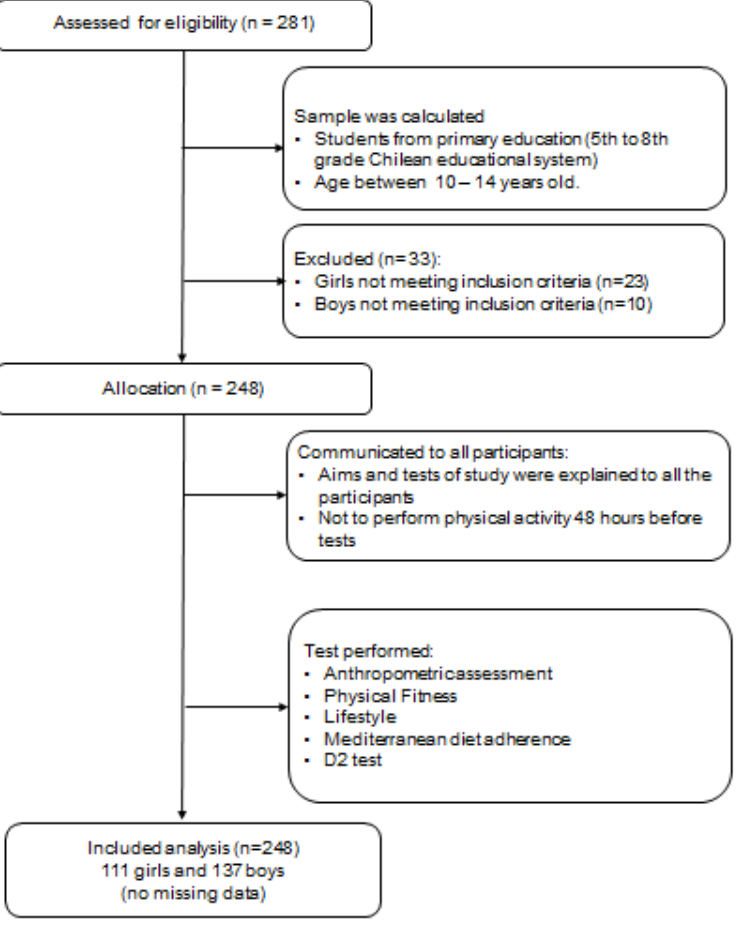
Figure 1. Study design.